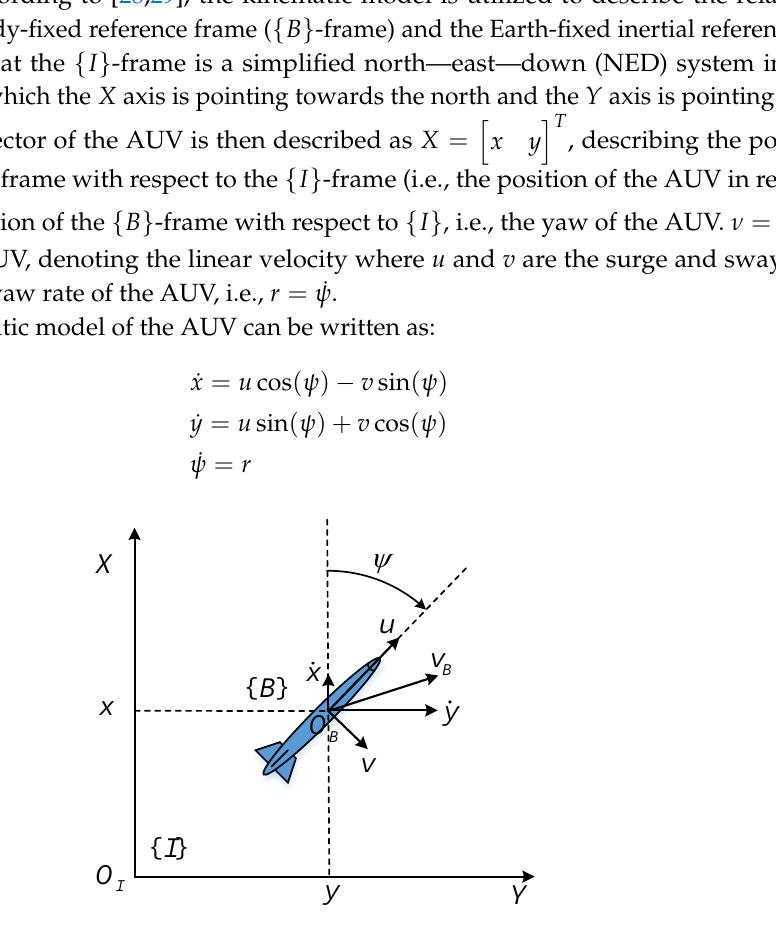
Figure 2. Two-dimensional model of the Autonomous Underwater Vehicle